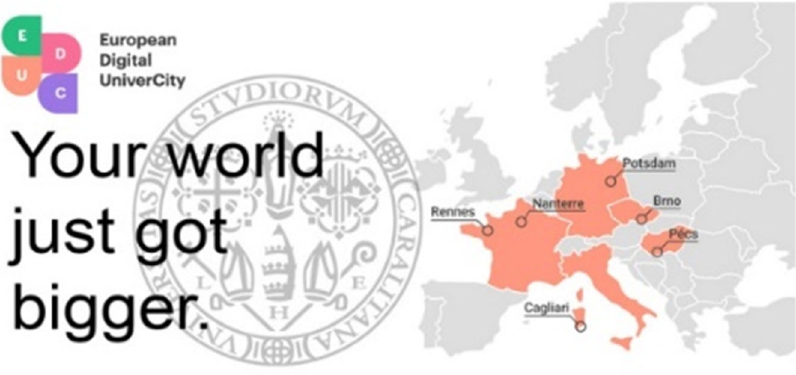
Fig. 1 EDUC alliance of academic scholars for novel methodology in online collaborative education. For further sources on the EDUC platform and the course see